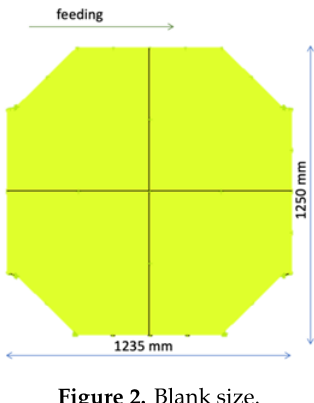
Figure 2. Blank Figure 2. Blank size. Figure 2. Blank size.